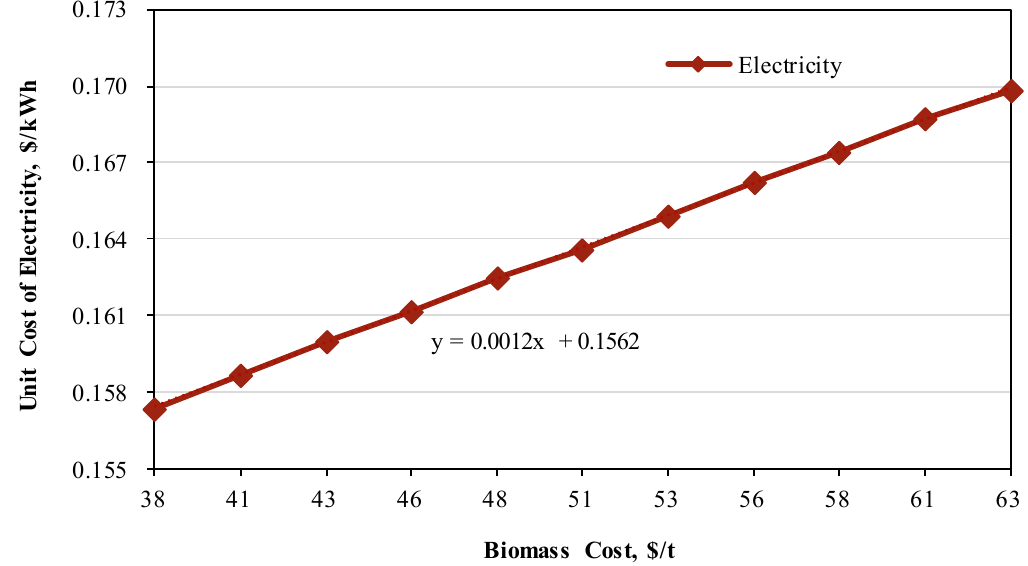
Figure 8. Variations of unit exergy cost of electricity with biomass cost.